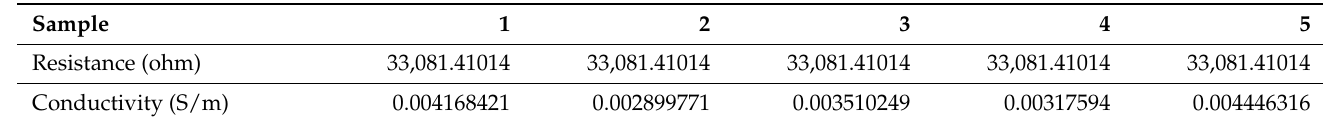
Table A18. Conductivity Data for Nylon 610 Nanocomposites with 2.5 wt% Untreated Graphite Nanosheets.